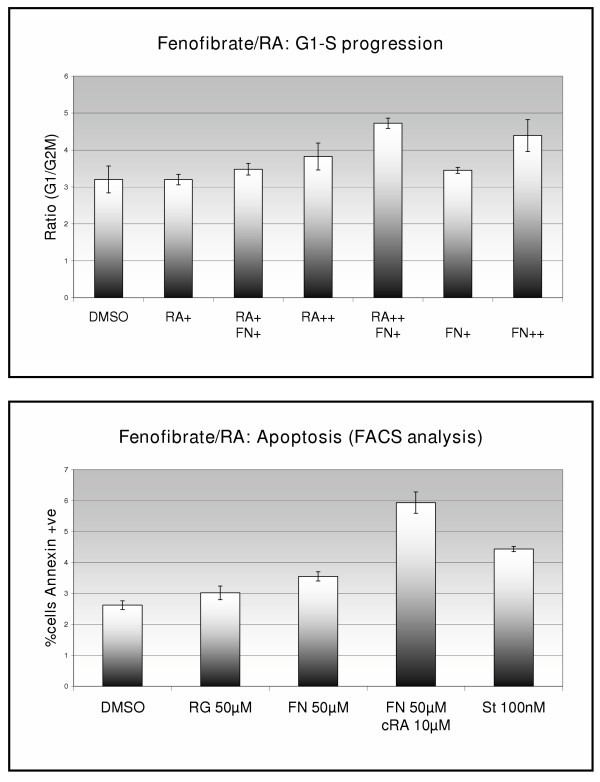
Top – DNA content analysis. The bars represent the ratio of cells in G1:G2M phase of the cell cycle after 12 hours of treatment with drug (RA+ = ATRA 10 μM. RA++ = ATRA 30 μM, FN+ = Fenofibrate 30 μM, FN++ = Fenofibrate 100 μM). Bottom – Apoptosis by FACS analysis using Annexin-FITC staining. Cells were treated for 3 hours. FN = fenofibrate, RG = rosiglitazone, St = staurosporine, a potent apoptogen.